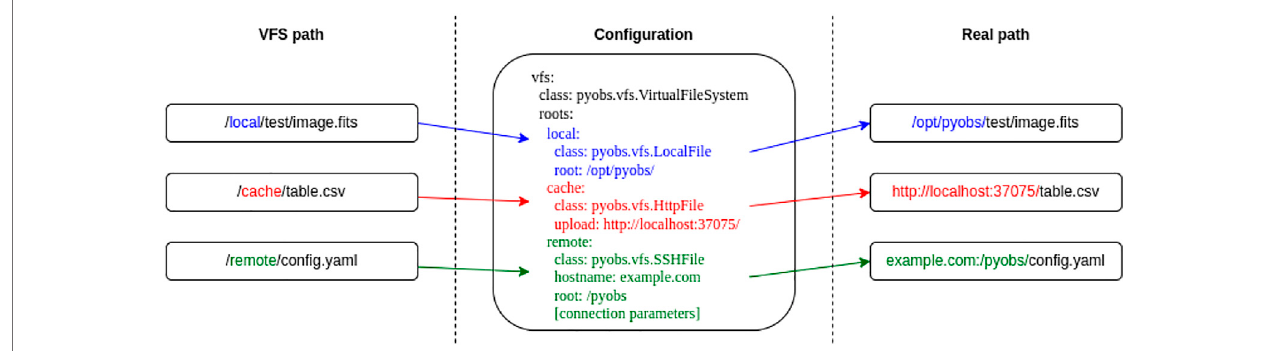
FIGURE3 | Some examples, how a VFS path (left) maps toa real path (right) witha given con fi guration (middle).Note thatfor the remote root the class SSHFile requires more parameters for the connection, which have been omitted here for clarity.